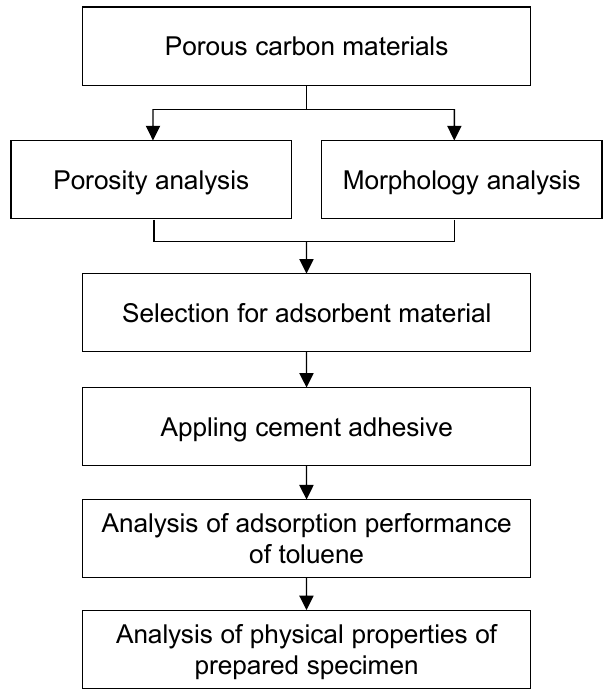
Figure 1. Flow diagram of the entire experiment.